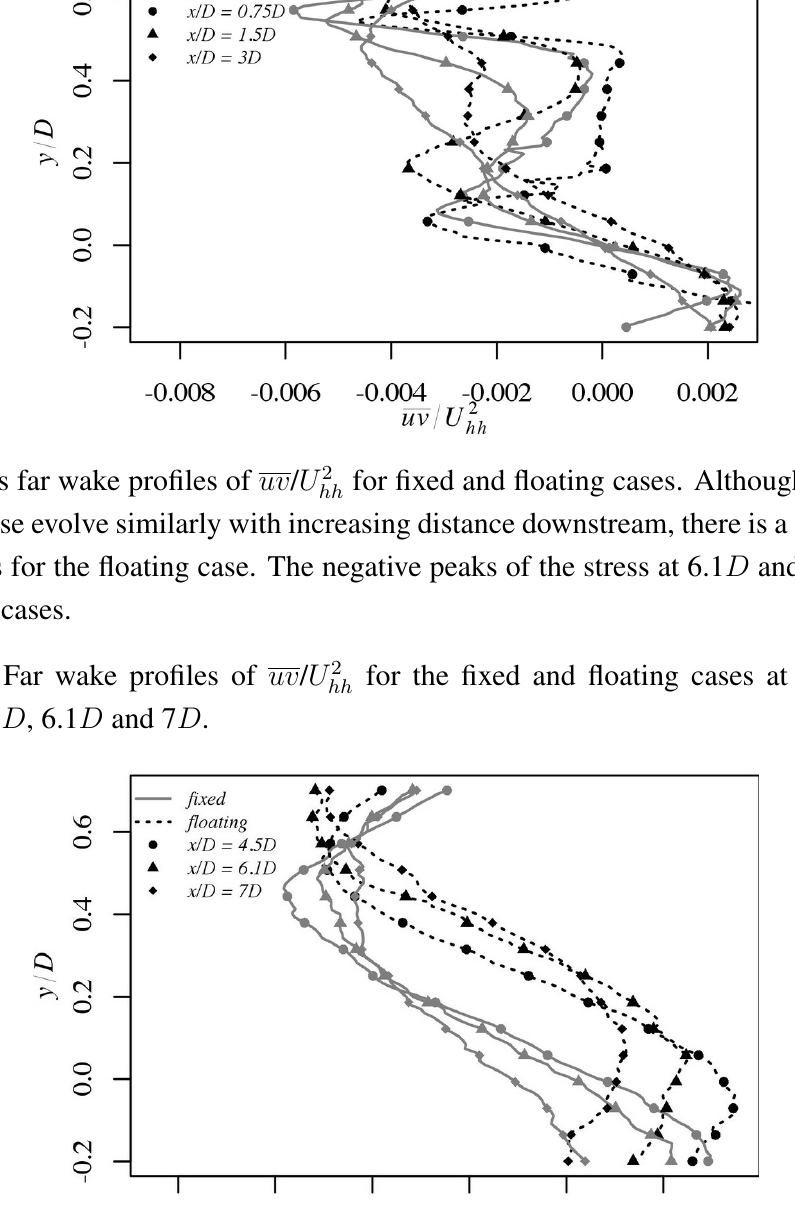
for the fixed and floating cases at downstream hh